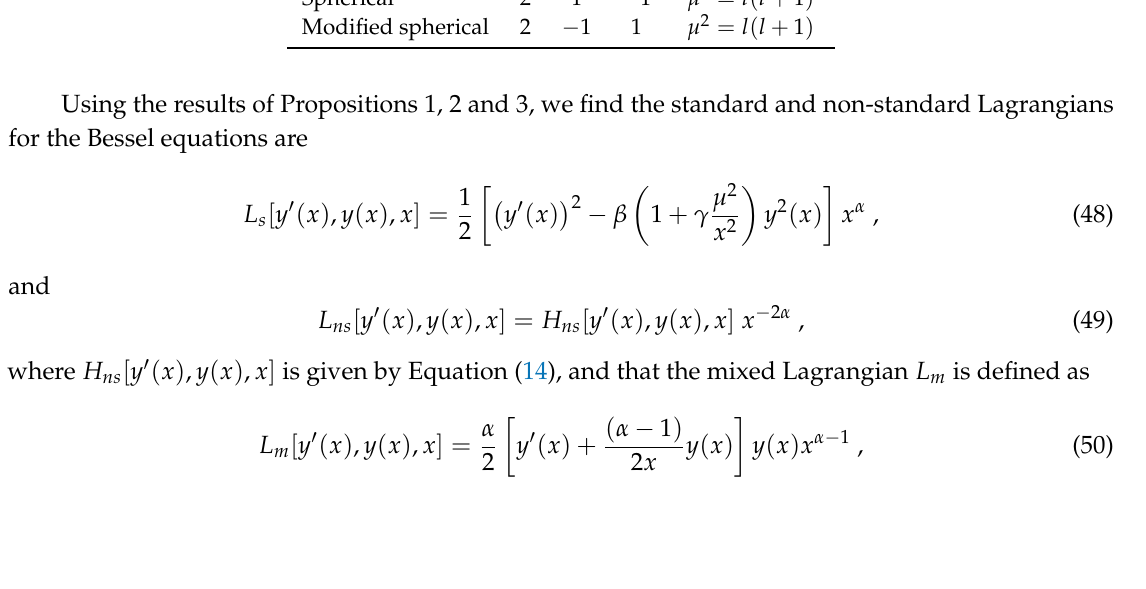
Table 1. Values of the constants α , β , γ and µ in Equation (47) corresponding to the four types of Bessel equations. Bessel Equations α β γ µ Regular 1 1 − 1 real or integer Modified 1 real or integer Spherical Modified